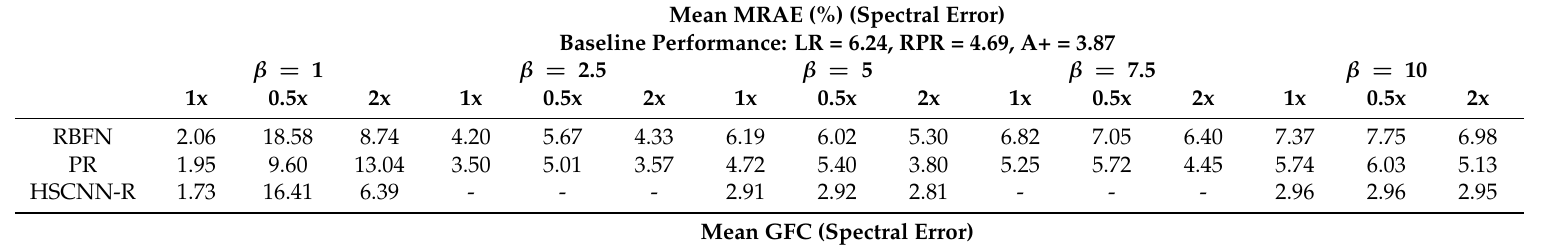
Table 2. The dependency of spectral and color accuracy on the β factor used for data augmentation. All models were tested under original ( 1x ), half ( 0.5x ) and double exposure settings ( 2x ). The MRAE, GFC and ∆ E 00 errors are calculated per pixel, and the mean results (over all pixels and images) are